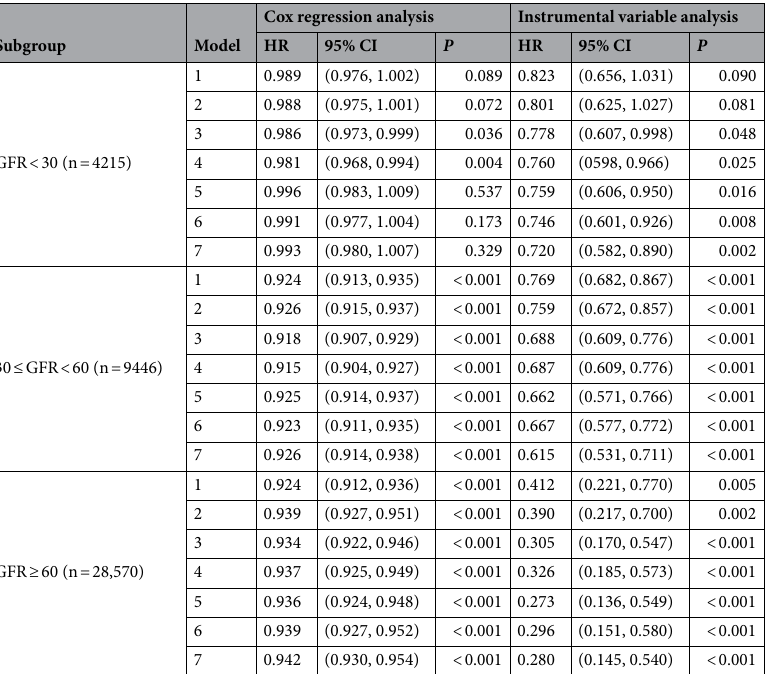
Table 4. Subgroup analysis for the risk of mortality according to the baseline GFR. Model 1: TCO 2 only. Model 2: Model 1 + history of hypertension and diabetes. Model 3: Model 2 + sex and age. Model 4: Model 3 + usage of sodium bicarbonate. Model 5: Model 3 + baseline kidney function as MDRD-GFR. Model 6: Model 5 + usage of sodium bicarbonate. Model 7: Model 6 + RAAS blockades + Diuretics group. CI confidence interval, GFR glomerular filtration rate, HR hazard ratio, TCO 2 total CO 2